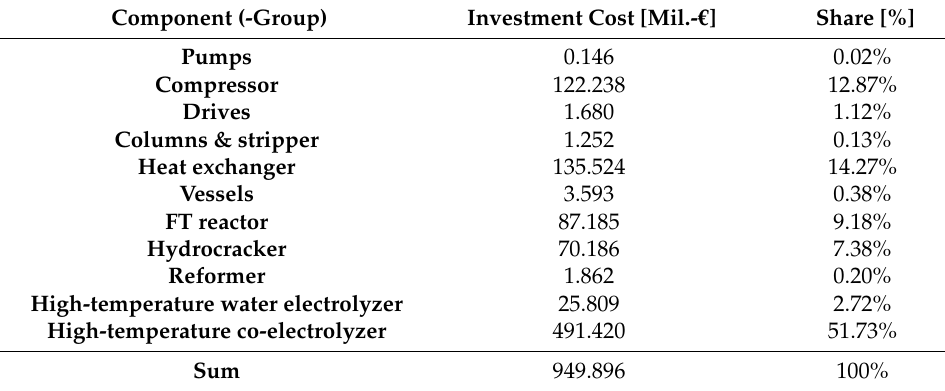
Table 4. Investment costs for the modeled power-to-fuel